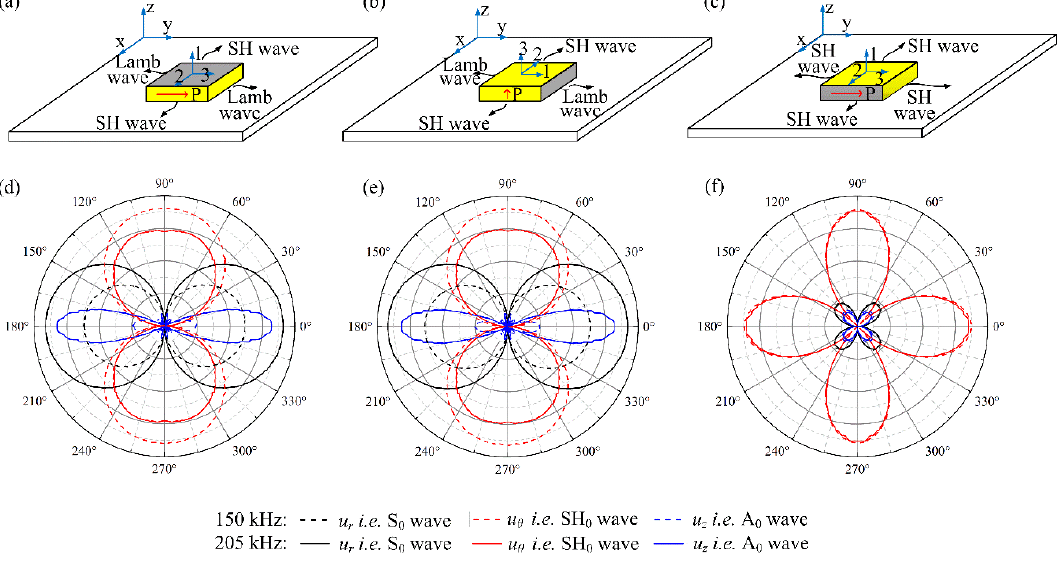
Figure 3. Illustration (up) and simulated results (bottom) of wave radiation patterns generated by using different shear modes piezoelectric wafers at 150 kHz and 205 kHz. ( a , d ): in ‐ plane poled d 15 mode; ( b , e ): thickness ‐ poled d 15 mode; ( c , f ): face shear d 24 mode.